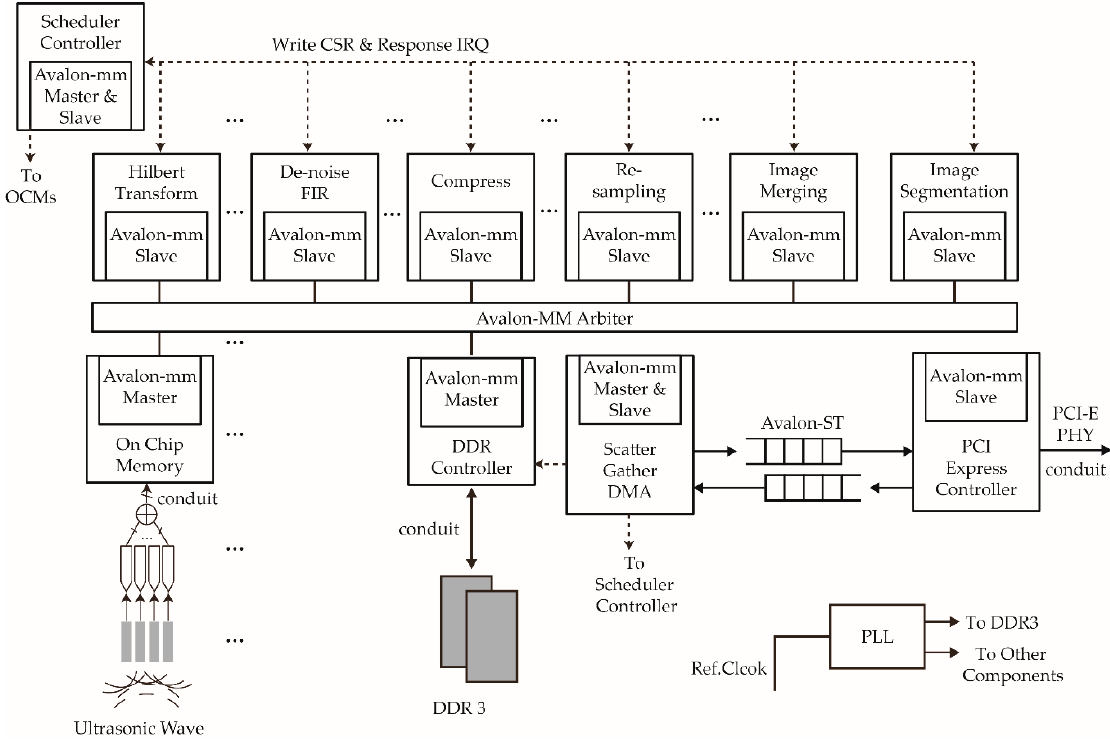
Figure 12. Architecture of the multigroup-scan ultrasound TFM system.